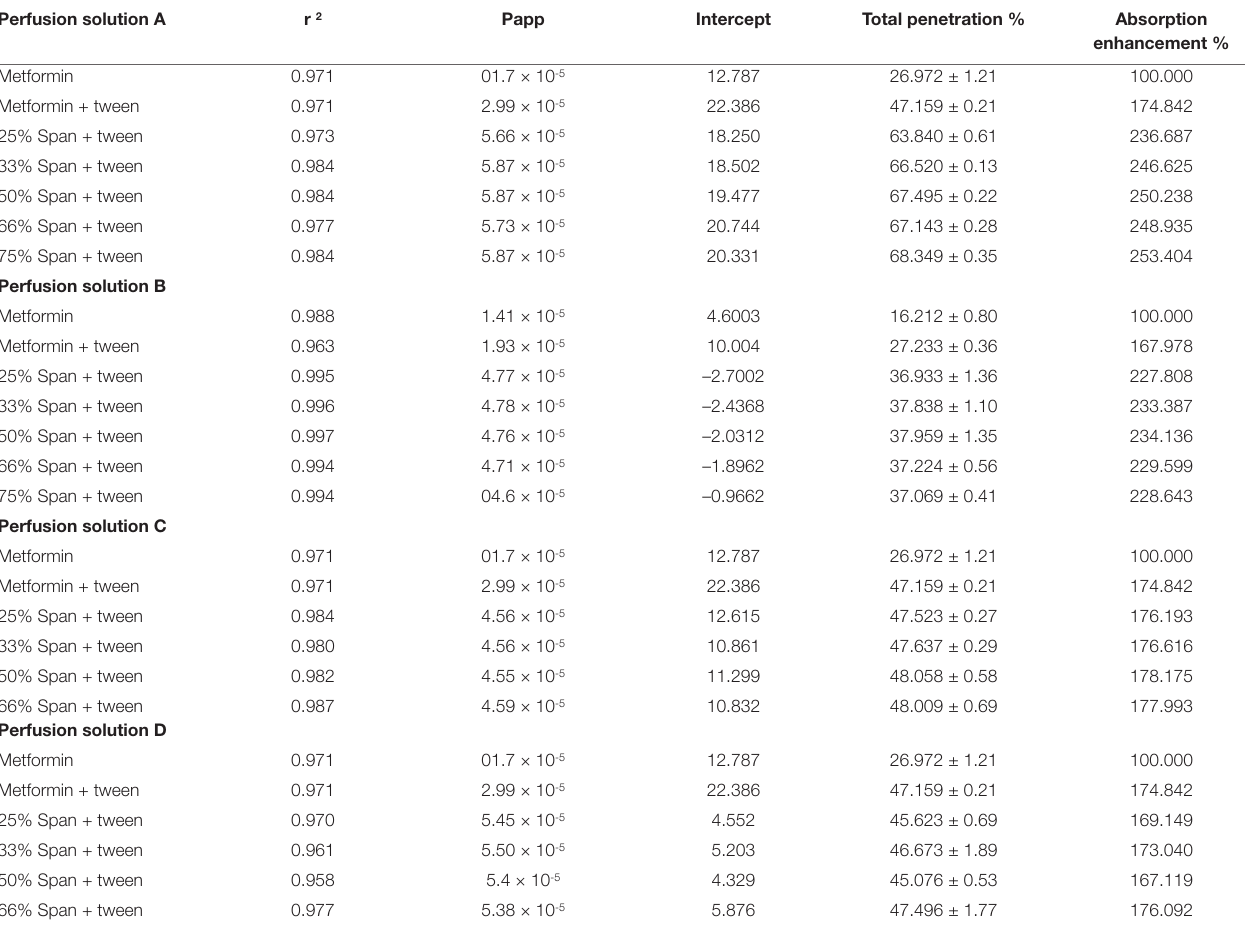
TABLE 6 | Data of metformin HCl Transferred through non-everted intestinal sac (Method two). Perfusion solution